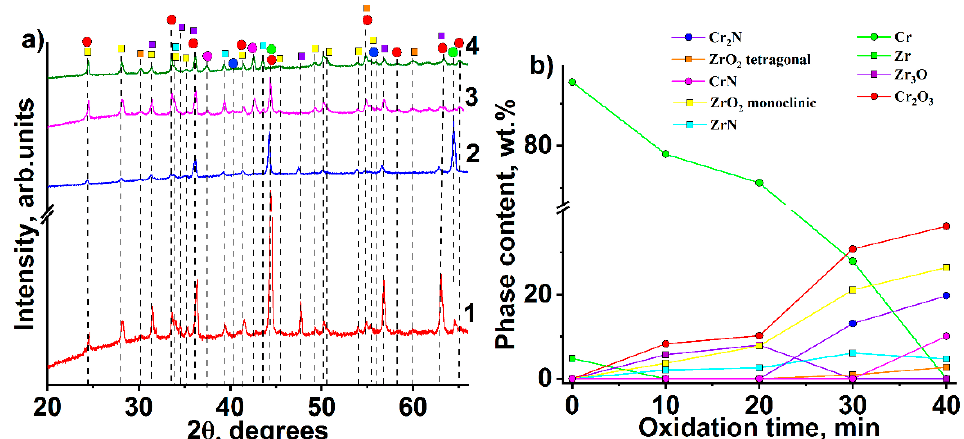
Figure 7. Diffraction patterns of the E110 alloy with the Cr coating after air oxidation at 1100 °C ( a ) and phase content ( b ) depending on oxidation time: 1–10 min, 2–20 min, 3–30 min, 4–40 min.